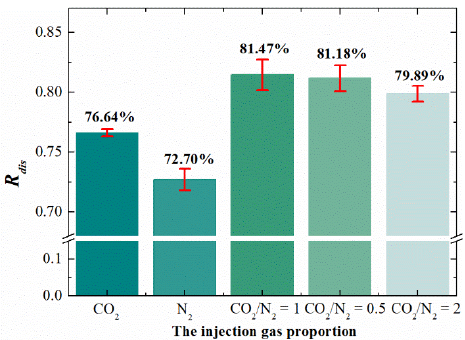
Figure 16. The displacement efficiency of CH 4 as a function of the gas proportion.